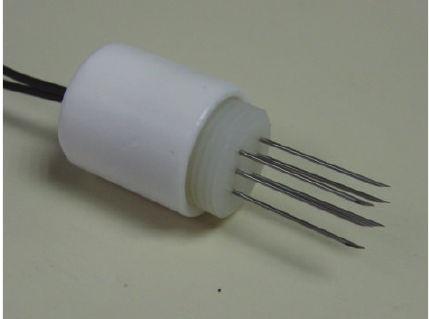
Figure 3: Six-needle electrode used to treat the patient. It consists of two rows of 3 needles. The separation of the rows is 0.8 cm; the separation between the needles in the same row is 0.4 cm. Each needle is 2 cm long and 1.2 mm in diameter.